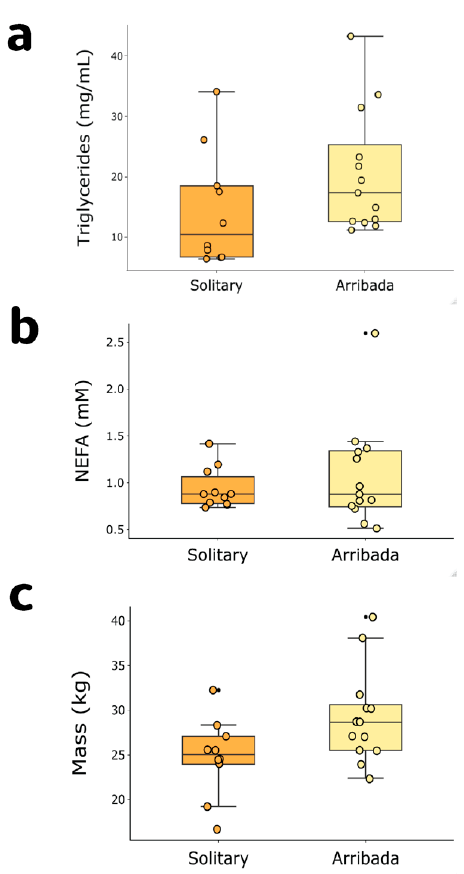
Figure A1. ( a ) Triglycerides ( p = 0.07), ( b ) NEFA ( p = 0.66), and ( c ) Mass ( p = 0.042) between solitary and arribada nesters.